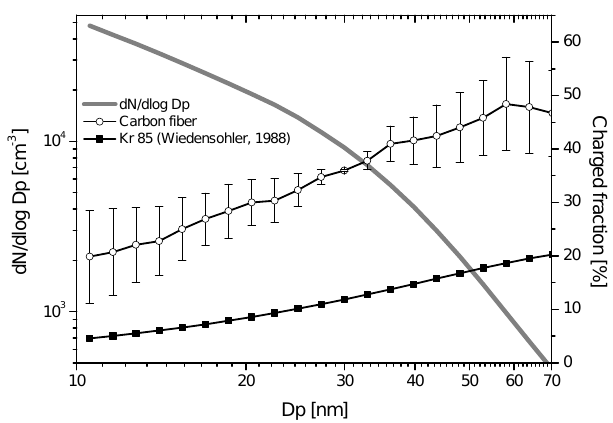
Fig. 2. Size-dependent extrinsic charging efficiency of the unipolar carbon fiber corona charger, and the theoretical charging efficiency of the bipolar charge equilibrium (Wiedensohler, 1988) for singly positive charged particles. Additionally, the number-size distribu- tion of the aerosol used for characterization is